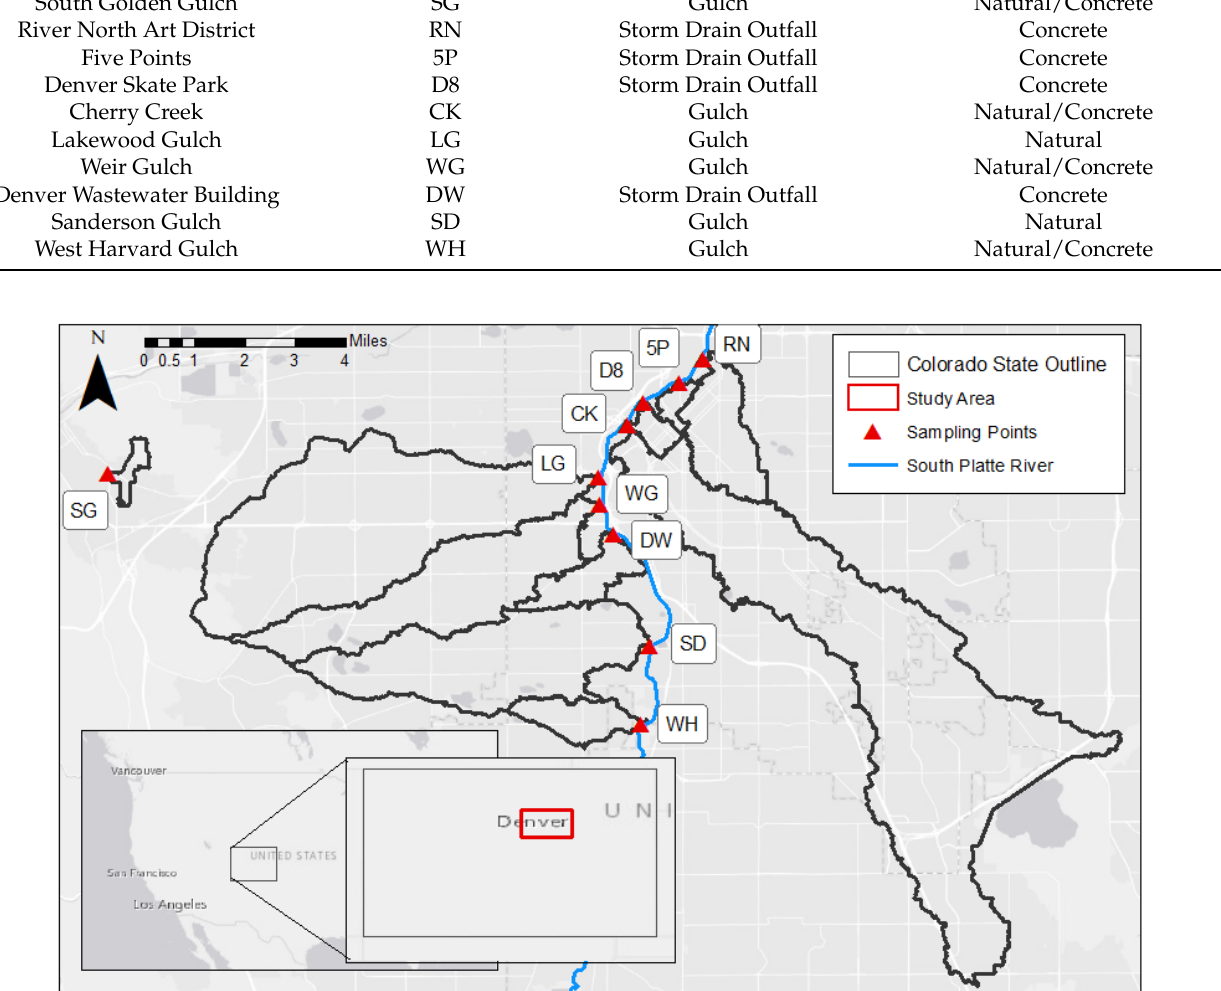
Figure 1. Study area with sampling locations and their respective drainage areas in Denver and Golden, Colorado.